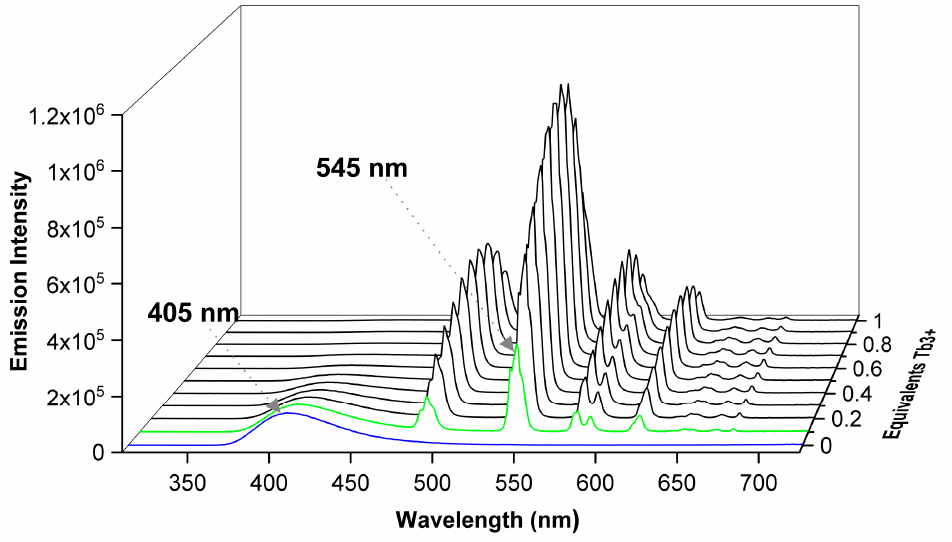
Figure 1. Fluorescence spectra representing the titration of ligand 1 (9.7 µ M, acetonitrile) with 0 to 1 equivalents of Tb(OTf) 3 . Excitation at 280 nm; excitation and emission slit widths are 2 and 1 nm, respectively. Integration time = 0.2 s.